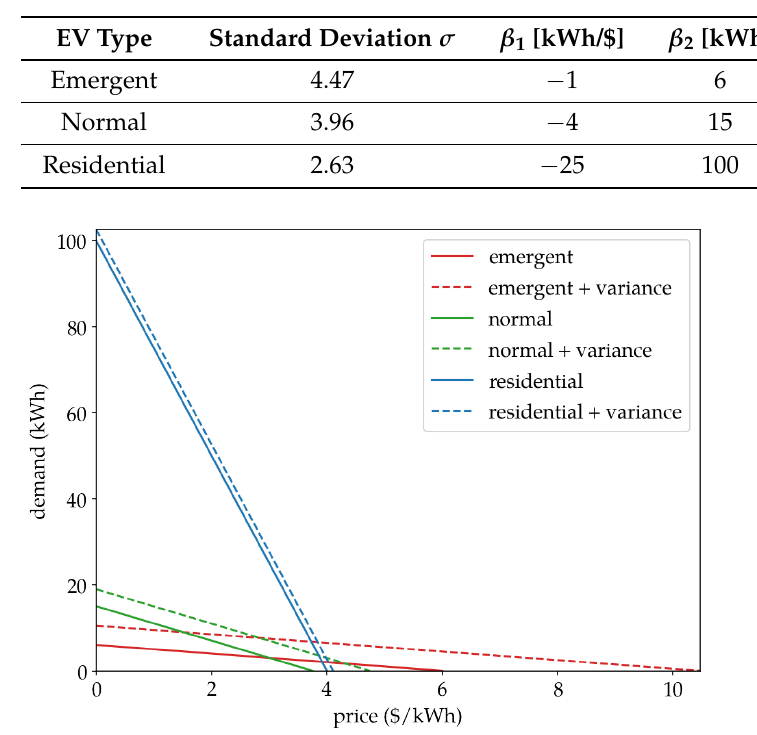
Figure 6. Plot of demand–response function for each EV